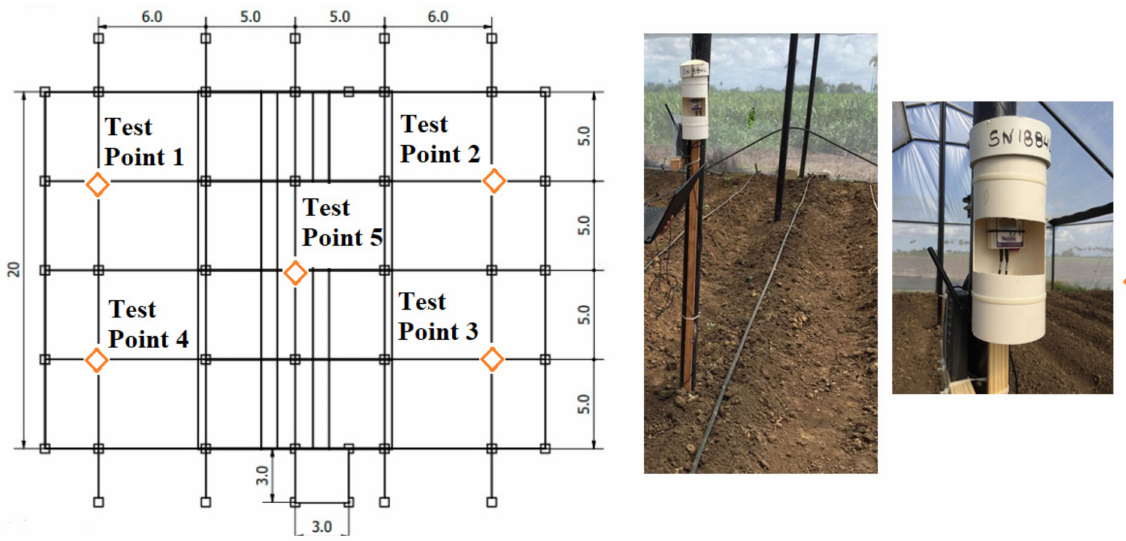
Figure 2. Schematic of the experimental climate data